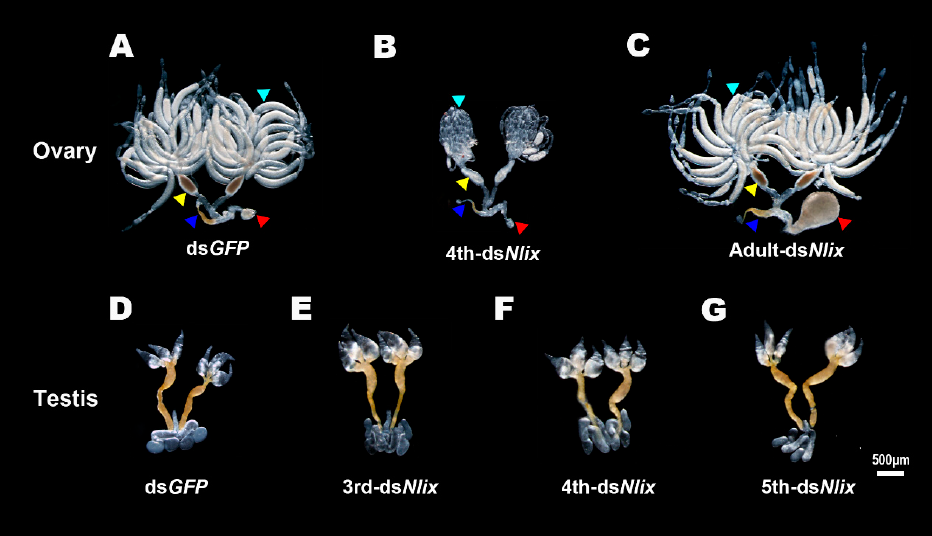
Figure 6. Phenotypes of gonad development upon Nlix knockdown in females or males. ( A – C ) The ovaries of BPH females treated with ds GFP , and ds Nlix for 4th instar nymphs and newly emerged adults. Red triangles: copulatory bursas; blue triangles: seminal receptacles, yellow triangles: lateral oviducts; and cyan triangles: oocytes. ( D – G ) The testes of BPH males were treated with ds GFP and ds Nlix for 3rd, 4th and 5th instar nymphs, respectively. ds GFP was injected as a negative control for the nonspecific effects of dsRNA. These internal reproductive systems were dissected from adults 4 days after